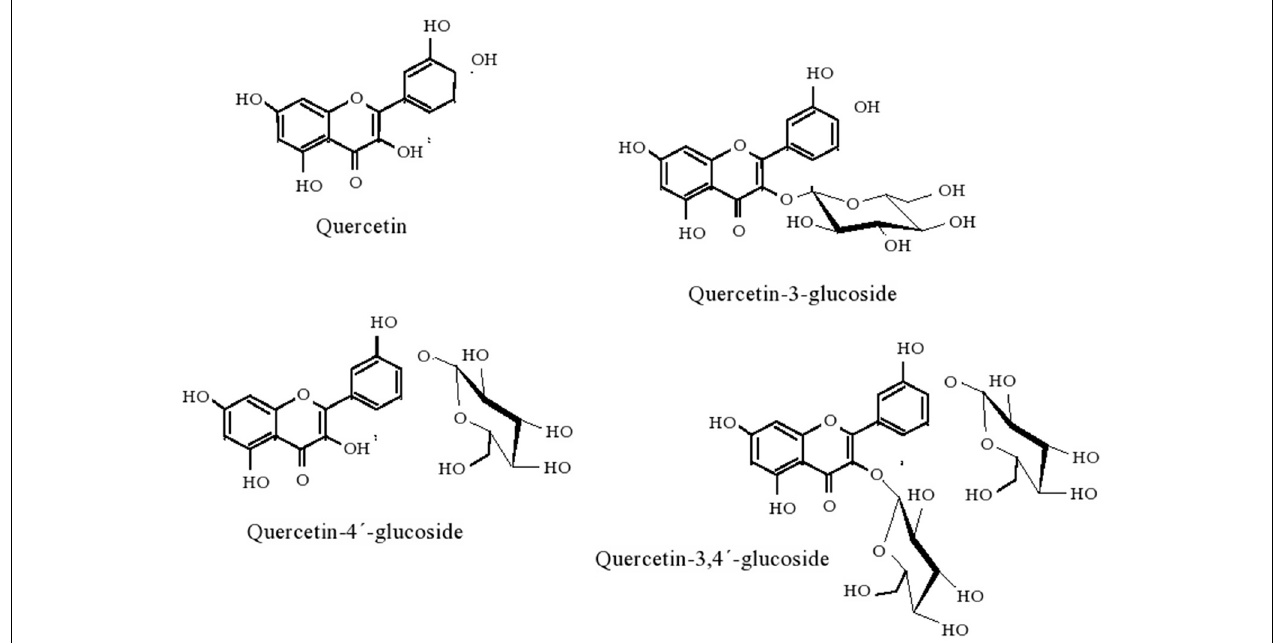
FIGURE 1 | Quercetin and quercetin glucosides resulting of given biotransformations.